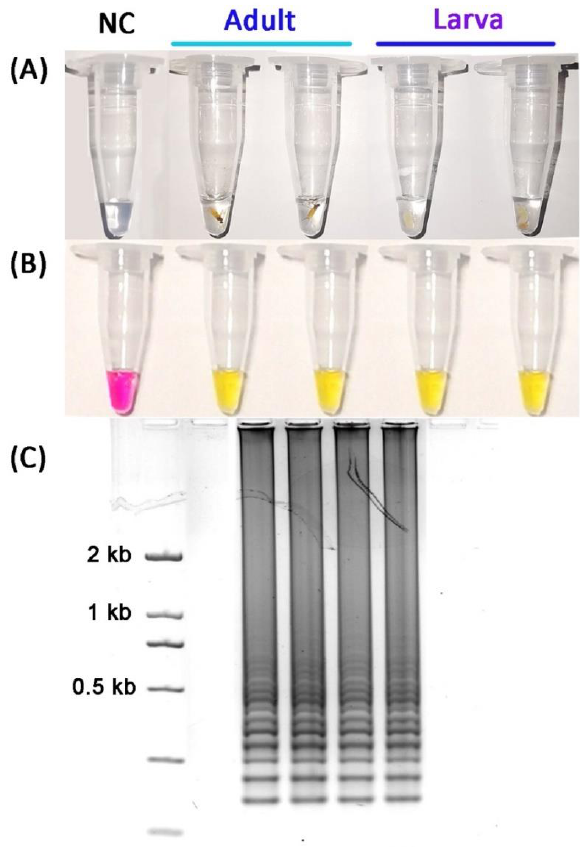
Figure 6. Identification of the “crude” gDNA extract using a non-destructive DNA extraction method with four LAMP primers. ( A ) Individual larva and adult, ( B ) under visible light, ( C ) under gel electrophoresis.